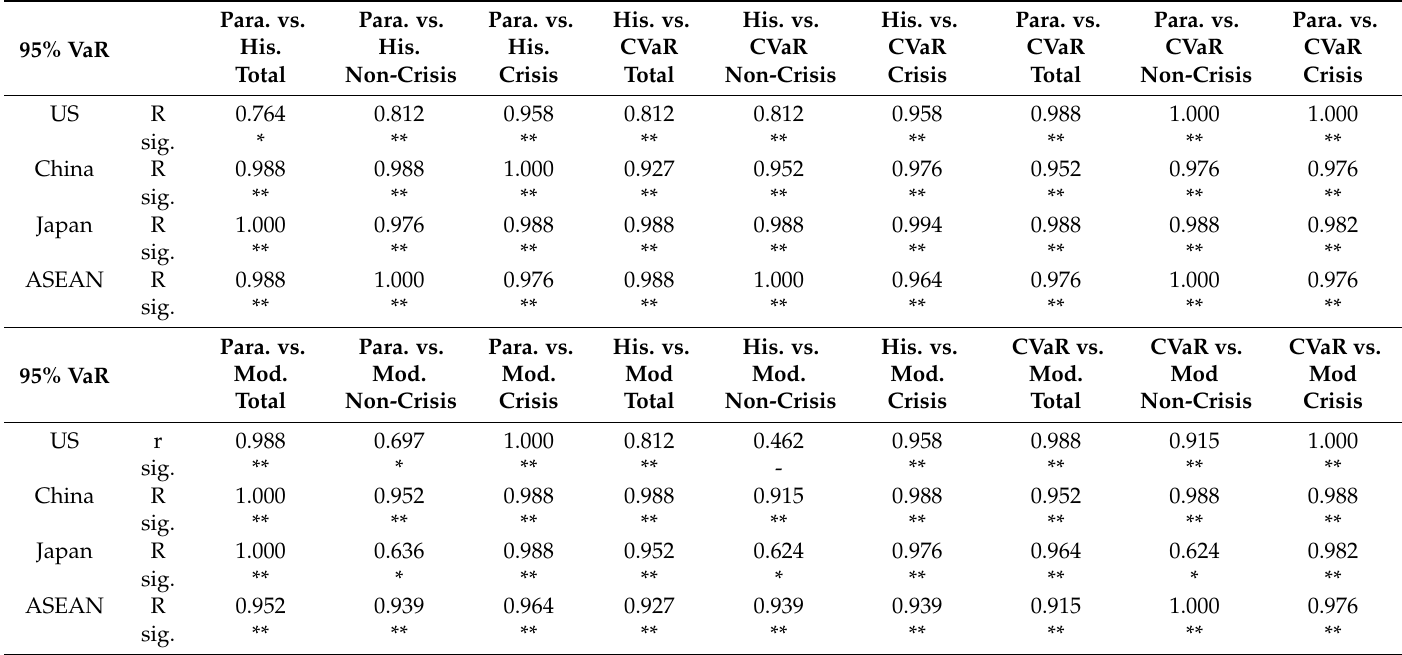
Table 4. Markowitz model ranking correlation of industries between different metrics (95% VaR and CVaR). Para. vs. Para. vs. Para. vs. His. vs. His. vs. His. vs. Para. vs. Para. vs. Para. vs. His. His. His. CVaR CVaR CVaR CVaR CVaR CVaR 95% VaR Total Non-Crisis Crisis Total Non-Crisis Crisis Total Non-Crisis Crisis US R 0.764 0.812 0.958 0.812 0.812 0.958 0.988 1.000 1.000 sig. * ** ** ** ** ** ** ** ** China R 0.988 0.988 1.000 0.927 0.952 0.976 0.952 0.976 0.976 sig. ** ** ** ** ** ** ** ** ** Japan R 1.000 0.976 0.988 0.988 0.988 0.994 0.988 0.988 0.982 sig. ** ** ** ** ** ** ** ** ** ASEAN R 0.988 1.000 0.976 0.988 1.000 0.964 0.976 1.000 0.976 sig. ** ** ** ** ** ** ** ** ** Para. vs. Para. vs. Para. vs. His. vs. His. vs. His. vs. CVaR vs. CVaR vs. CVaR vs. Mod. Mod. Mod. Mod Mod. Mod. Mod. Mod Mod 95% VaR Total Non-Crisis Crisis Total Non-Crisis Crisis Total Non-Crisis Crisis US r 0.988 0.697 1.000 0.812 0.462 0.958 0.988 0.915 1.000 sig. ** * ** ** - ** ** ** ** China R 1.000 0.952 0.988 0.988 0.915 0.988 0.952 0.988 0.988 sig. ** ** ** ** ** ** ** ** ** Japan R 1.000 0.636 0.624 0.982 sig. ** *